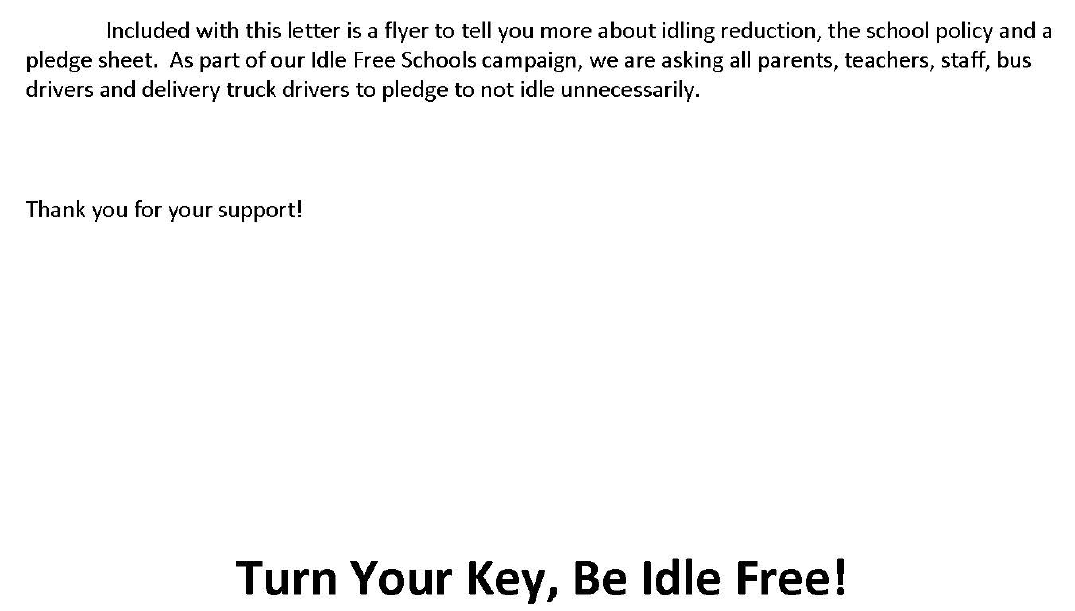
Figure A8. Idle-free schools letter to teachers and staff.